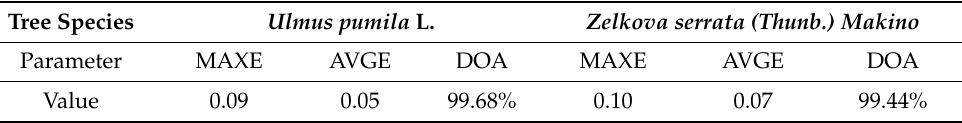
Table 5. The measurement results and goodness of fit of the model. MAXE is the maximum error value of the measurement result. AVGE is the average error value of the measurement results. DOA represents the degree of accuracy of the measurement results.